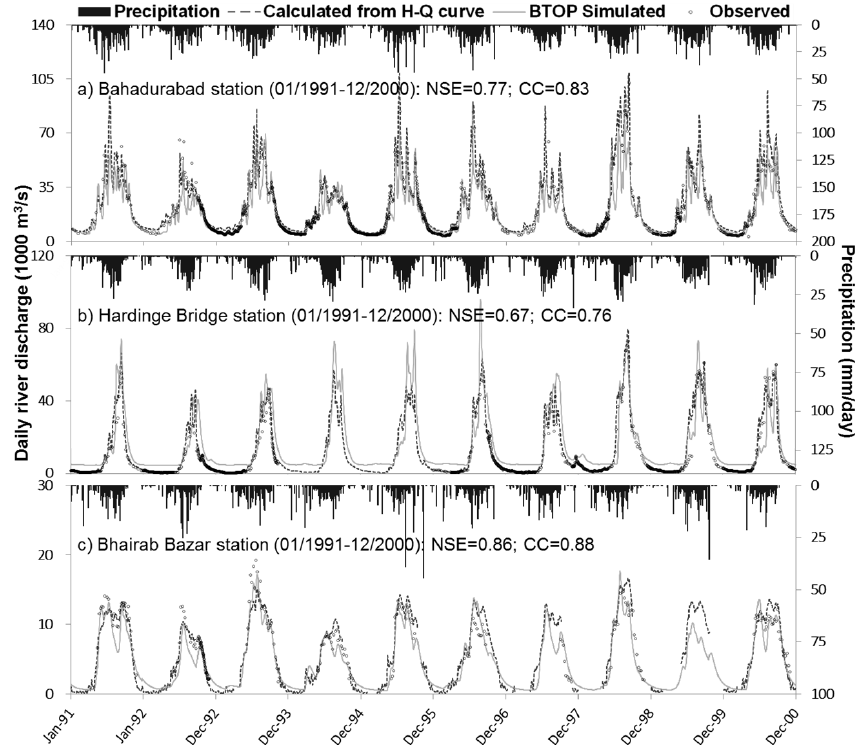
Figure 4. Daily river discharges for the BTOP model validation at Bahadurabad (a) , Hardinge Bridge (b) , and Bhairab Bazar (c)